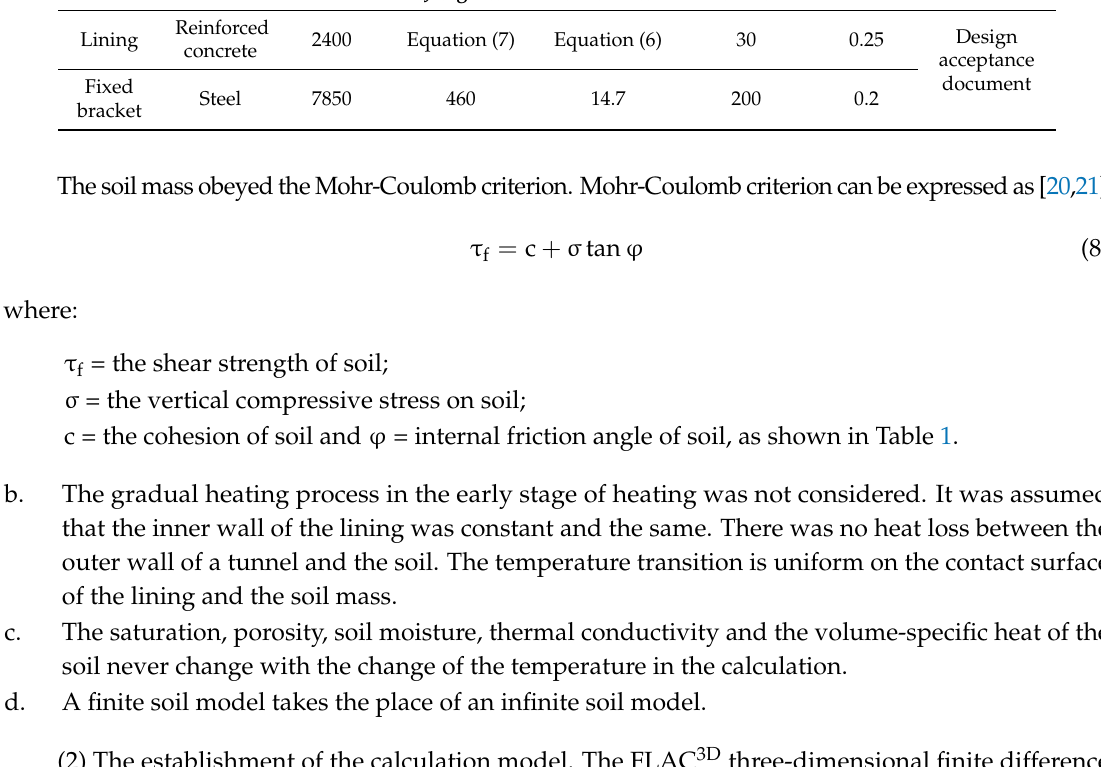
Table 3. Parameters of structure.